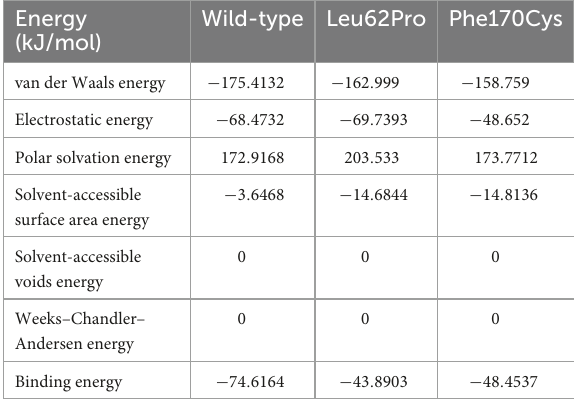
TABLE 3 Binding energy of the NARS2 protein dimer affected by